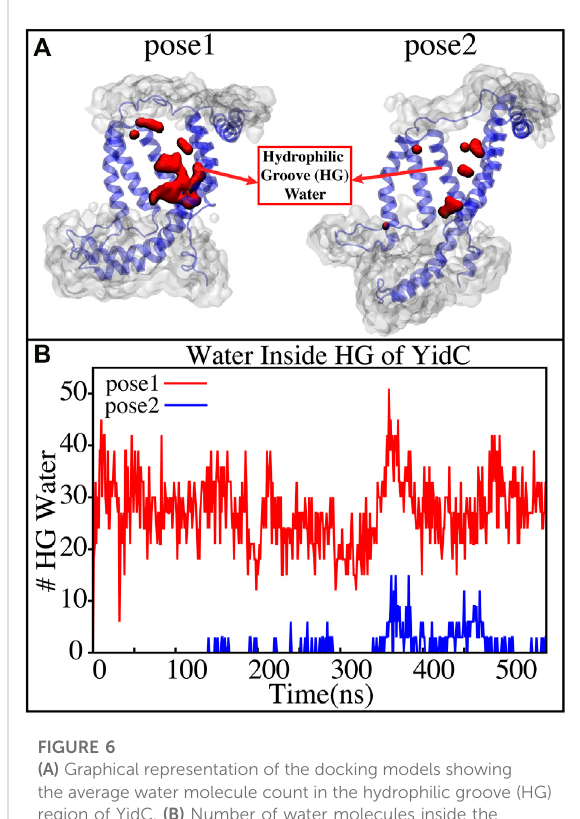
FIGURE 6 (A) Graphical representation of the docking models showing the average water molecule count in the hydrophilic groove (HG) region of YidC. (B) Number of water molecules inside the hydrophilic groove (HG) region of YidC in docking poses 1 (red) and pose 2 (blue).Pf3 coat protein entry into the TM area